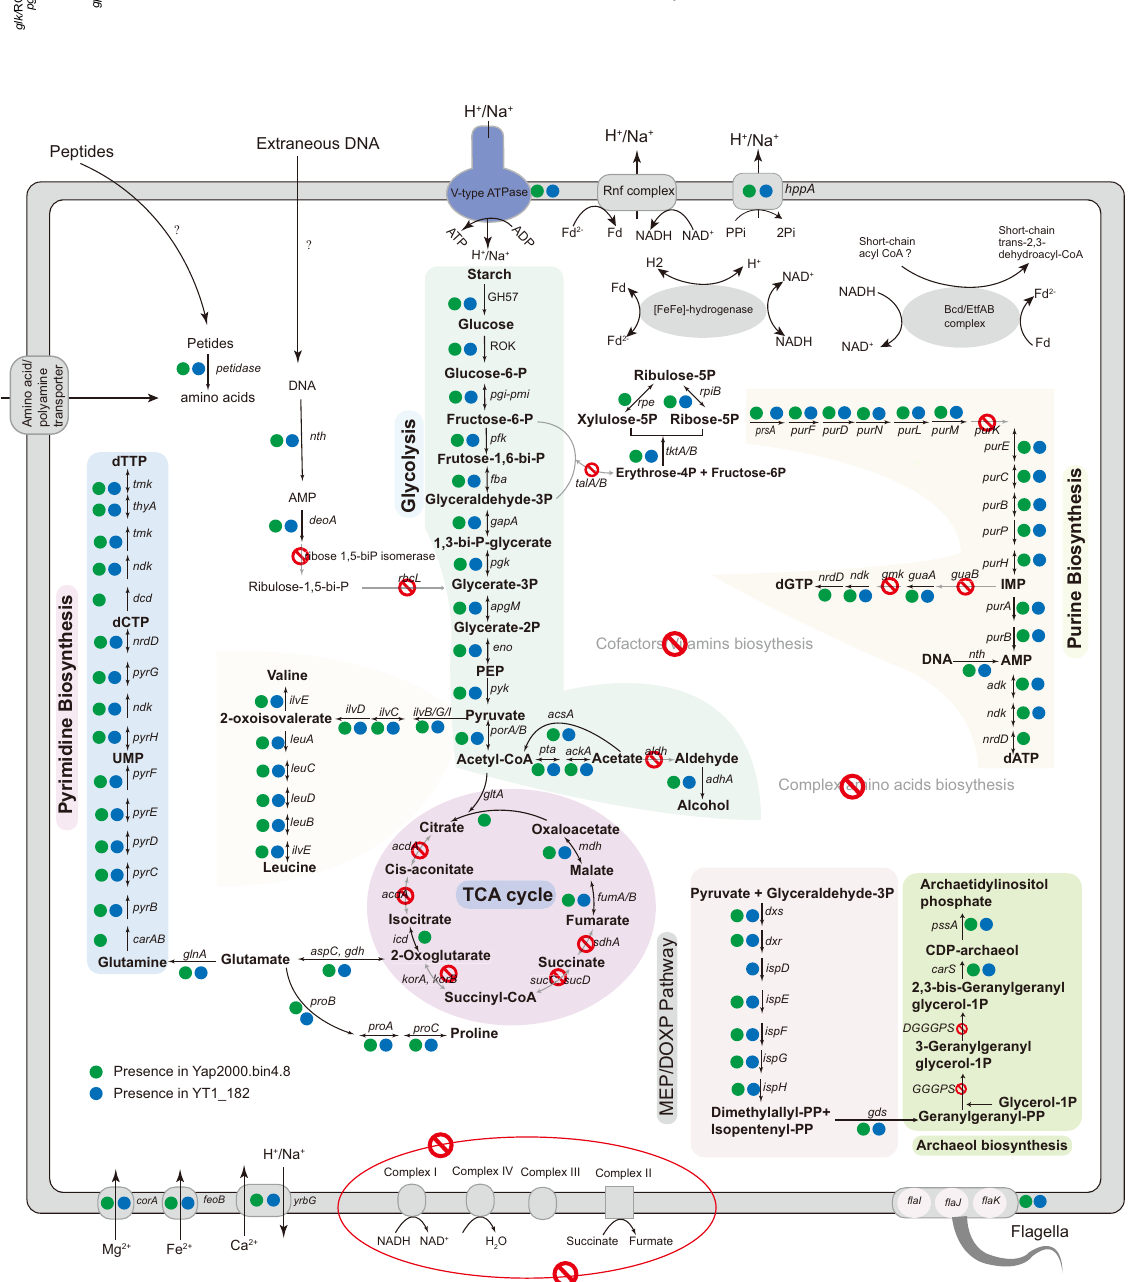
Fig. 3 Metabolic comparison of Woesearchaeota subgroups. a Occurrence of a gene of interest in different subgroups of Woesearchaeota. The occurrence was calculated in percent across the total number of genomes included in each subgroup based on the presence/absence table. Raw data are available in Supplementary Data 3. b Reconstructed metabolic pathways of two MAGs from subgroup J, YT1_182 (estimated to be 94.61% complete and 1.96% contaminated) and Yap2000.bin4.8 (estimated to be 94.61% complete and 3.92% contaminated). A detailed list of genes encoded by these two MAGs can be found in Supplementary Data 4. Source data are provided as a Source Data fi